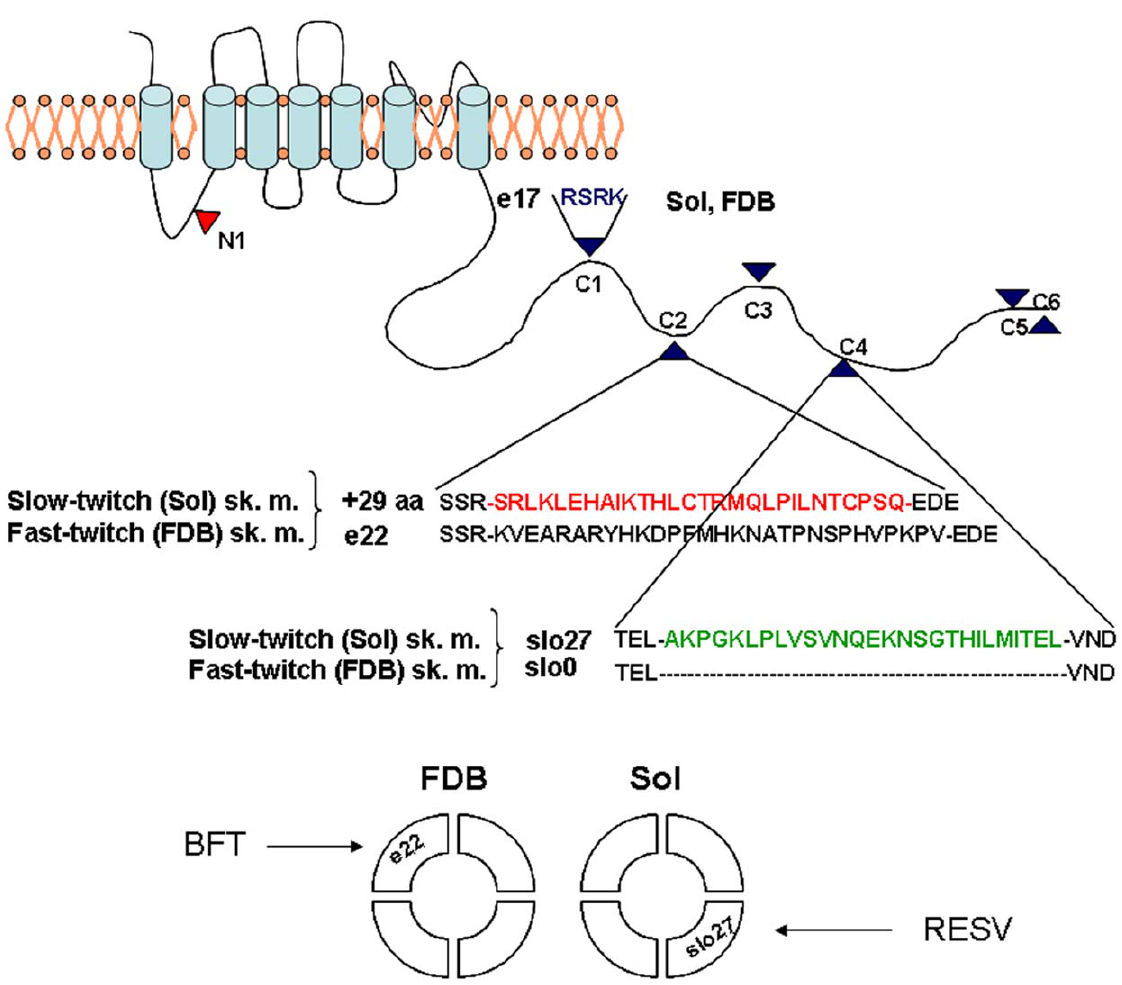
Figure 7. Schematic illustrating BK channel structure and sites of variable splicing in the BK alpha-subunit of slow-twitch soleus (Sol) and fast-twitch flexor digitorum brevis (FDB) skeletal muscles, and the related channel models. Five variants were found in the slow-twitch and fast-twitch skeletal muscles: e17 in C1, + 29aa or e22 in C2, and Slo27 or Slo0 in C4 sites. These variants participate in the composition of the tetramers. The variants e22 and Slo27 characterizing the BK channels of the FDB and Sol muscle phenotypes, respectively, are shown. BK channels containing e22 variant are sensitive to bendroflumethiazide (BFT) while those containing Slo27 are sensitive to resveratrol (RESV).